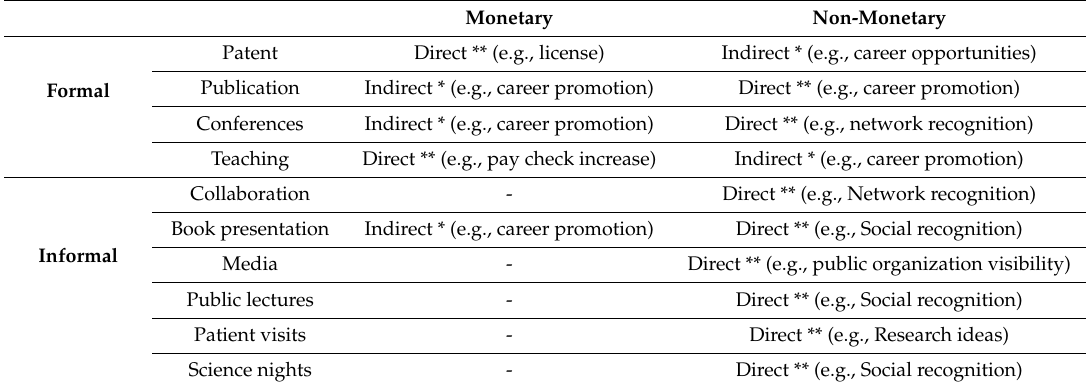
Table 2. Value capture mechanisms in science.